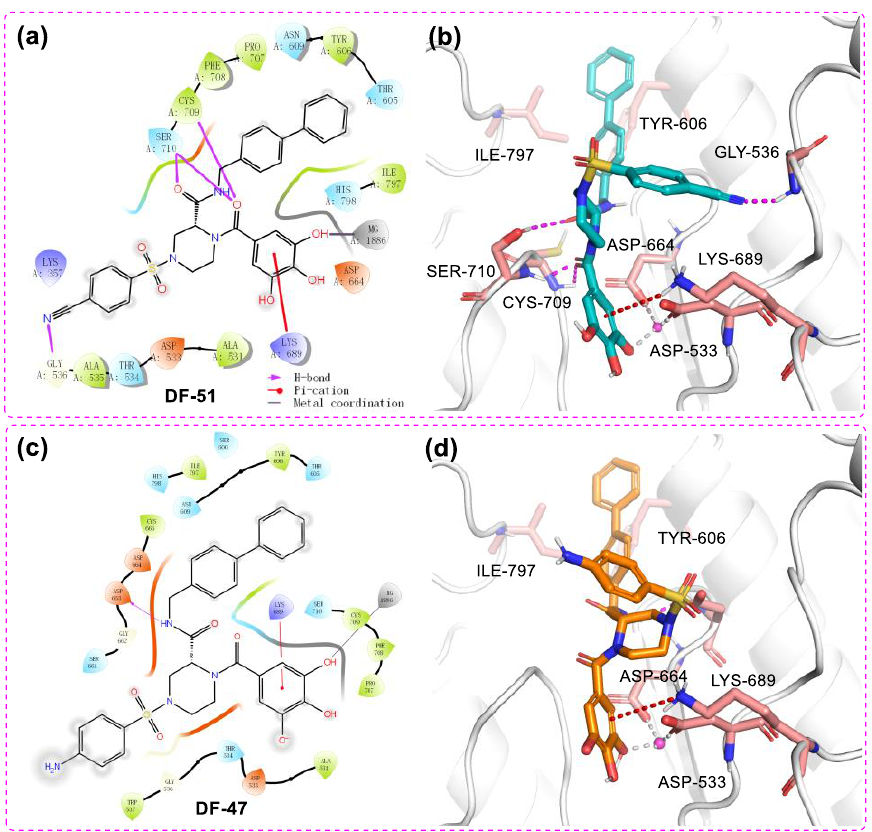
Figure 5. The 2D ligand–protein interaction diagram ( a )/3D docking pose ( b ) of DF-51 with DENV3 NS5 and the 2D ligand–protein interaction diagram ( c )/3D docking pose ( d ) of DF-47 with DENV3 NS5 RdRp domain (PDB ID: 2J7U). The pink spheres represent Mg 2+ . The purple arrows represent the hydrogen bonds; the red line represents Pi–cation interaction; the gray line represents metal coordination.